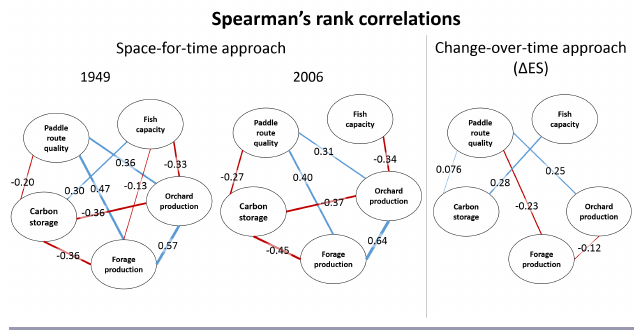
Fig. 7 . Interaction diagrams for five ecosystem services. Correlations between ecosystem services were determined using two different approaches: space-for-time substitution (left) and change-over-time (right). Circles represent different ecosystem services. Significant Spearman’s rank correlation coefficients (p < 0.05) are represented with different colored lines. Blue lines indicate ecosystem service synergies, red lines trade-offs. Ecosystem services not connected by lines were not significantly correlated. Line width is scaled based on strength of